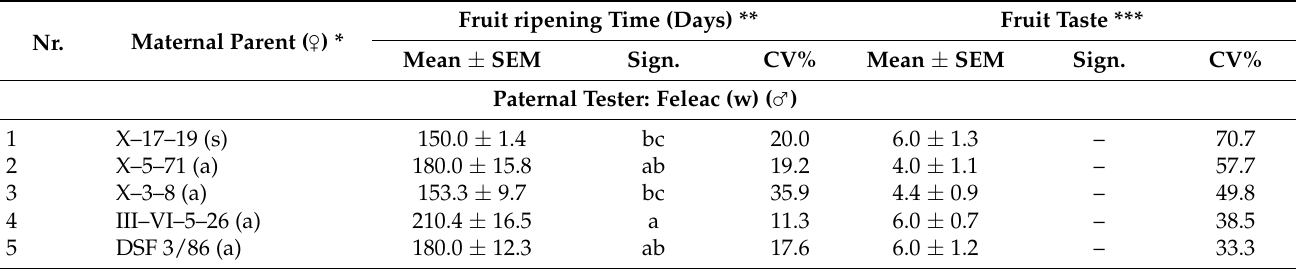
Table A3. Fruit ripening time expressed as the number of days required from the beginning of flowering to optimal fruit consumption maturity and fruit taste in F 1 apple hybrids in the offspring of testcross hybridization with the five cultivars used as paternal